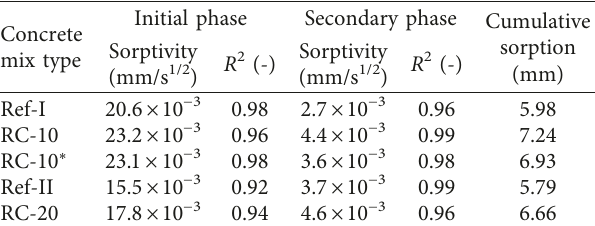
Figure 6: The amount of absorbed water by the concrete specimens versus square root of time. Table 6: Sorptivity and cumulative sorption of all concrete